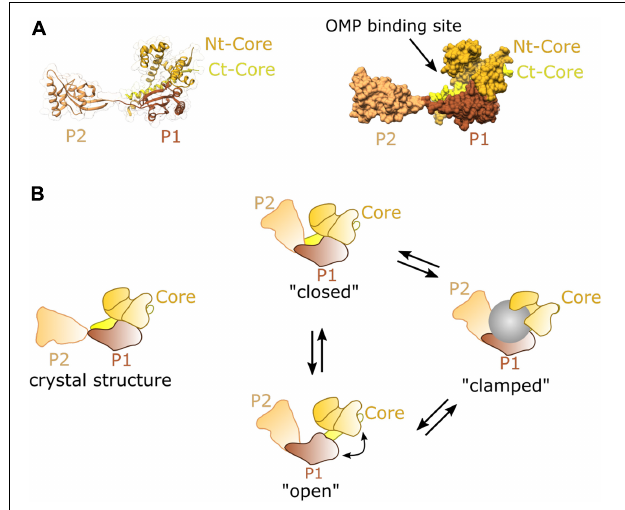
FIGURE 5 | Structure and dynamics of SurA. (A) Cartoon (left) and surface (right) representations of the crystal structure of SurA from E. coli PDB:1M5Y (Bitto and McKay, 2002). This contains a core domain consisting of the N and C terminal sequences, and P1 and P2 parvulin-like PPIase domains. (B) A model of dynamic movements between conformations distinct from the crystal structure as revealed from single molecule FRET experiments, adapted from Calabrese et al.